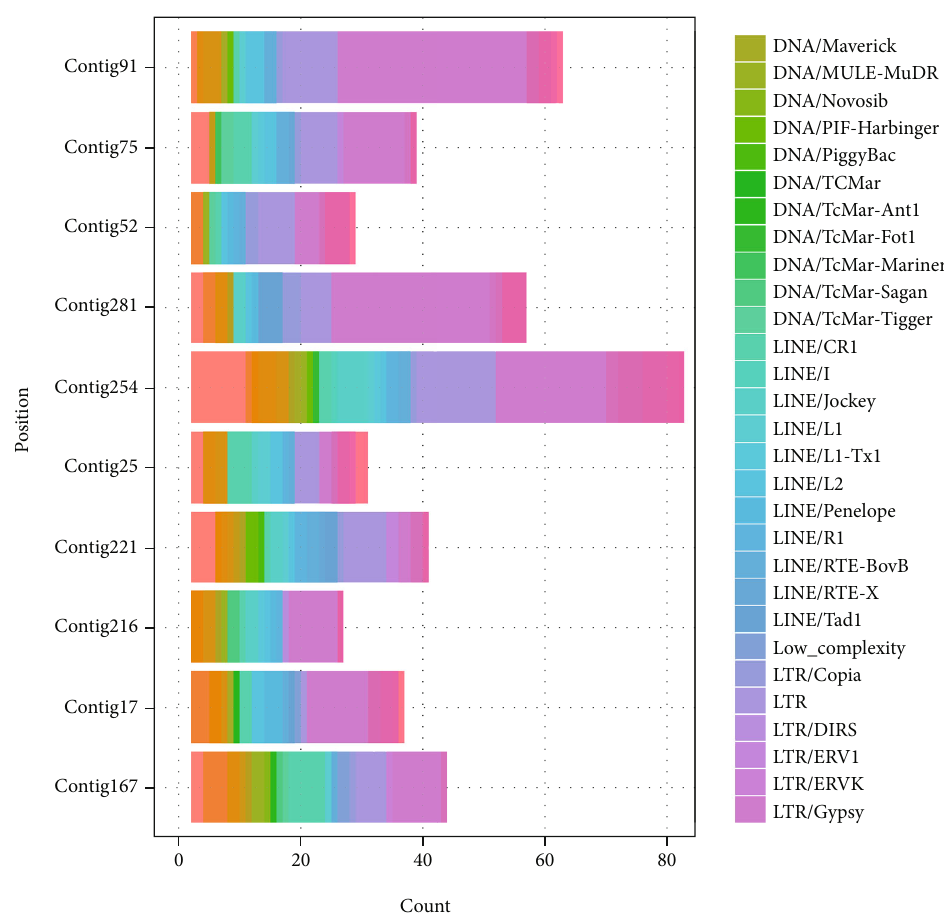
Figure 2: Composition of repeated sequences in each chromosome in the genome. Title is the class and family of repetitive DNA shown as DNA TIRs (terminal inverted repeats), LINEs (long interspersed nuclear elements), and LTRs (long terminal repeat). The family of TIRs of H. coralloides are shown as Maverick (virus-like DNA transposon), MULE-MuDR (Mutator-like transposable elements-MuDR transposon), Novosib (Novosib transposon), PIF-Harbinger (PIF-Harbinger transposon), PiggyBac (PiggyBac transposon), and TcMar (TcMar transposon). Table 6: Results of noncoding RNA (ncRNA) prediction.